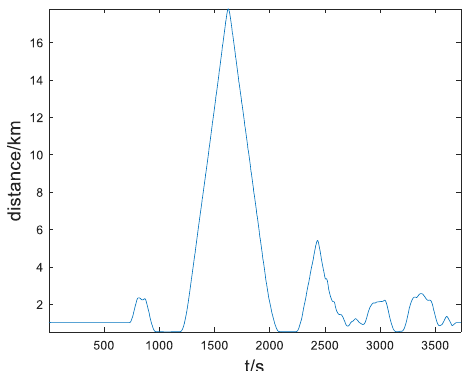
Figure 5. Robinson R44 helicopter distance from the microphone.